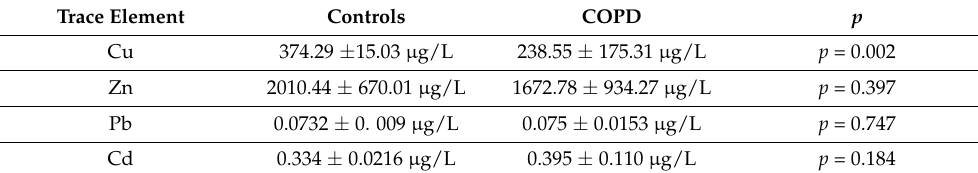
Table 2. Serum concentration of trace elements in controls and COPD